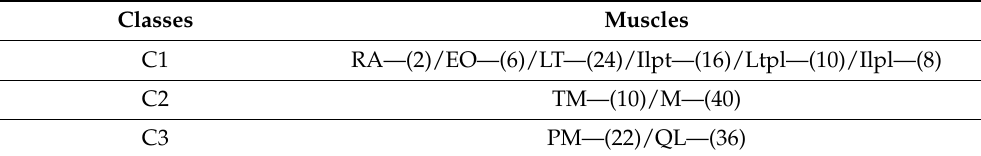
Table 2. Muscles of the three classes.